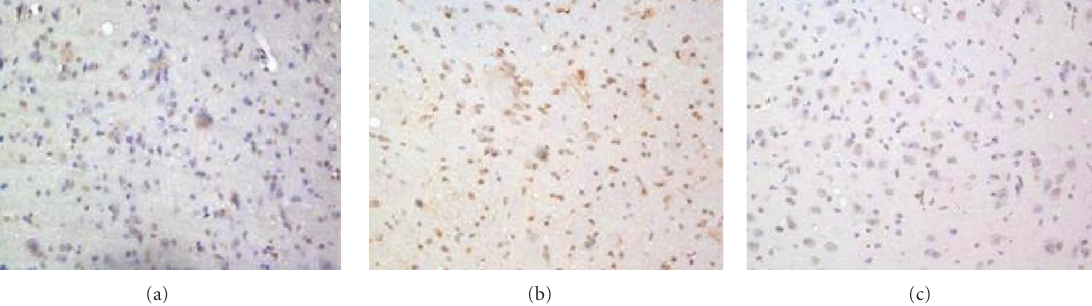
Figure 2: Apoptotic cells in each group (TUNEL × 400). (a) Almost no cell is positive for TUNEL in sham group. (b) Many cells are positive for TUNEL in I/R group. Nucleuses that are brownish or dark brown are positive. (c) A few cells are positive for TUNEL in PCr group.